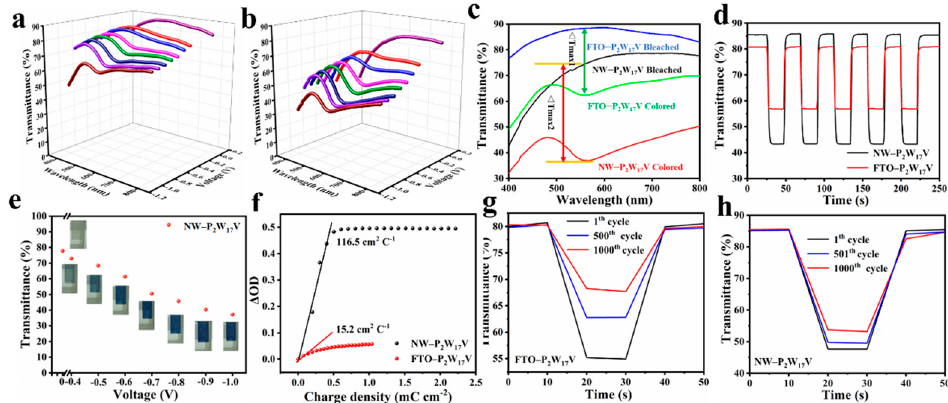
Figure 4. Visible transmittance spectrum of FTO − P 2 W 17 V ( a ) and NW − P 2 W 17 V ( b ) films at different potentials. ( c ) Visible spectra of prepared films at colored and bleached state; ( d ) Chronoamper- ometry measurements and corresponding in situ optical transmittance curves for FTO − P 2 W 17 V and NW − P 2 W 17 V films at 580 nm; ( e ) Plots of the transmittance value versus applied voltage for NW − P 2 W 17 V and corresponding optical images; ( f ) Coloration efficiency at 580 nm of NW − P 2 W 17 V and FTO − P 2 W 17 V films during subsequent double-potential steps ( − 1 V and +1 V); Cycle stability of FTO − P 2 W 17 V ( g ) and NW − P 2 W 17 V films ( h ) at 580 nm under square wave potentials of − 1 V and +1